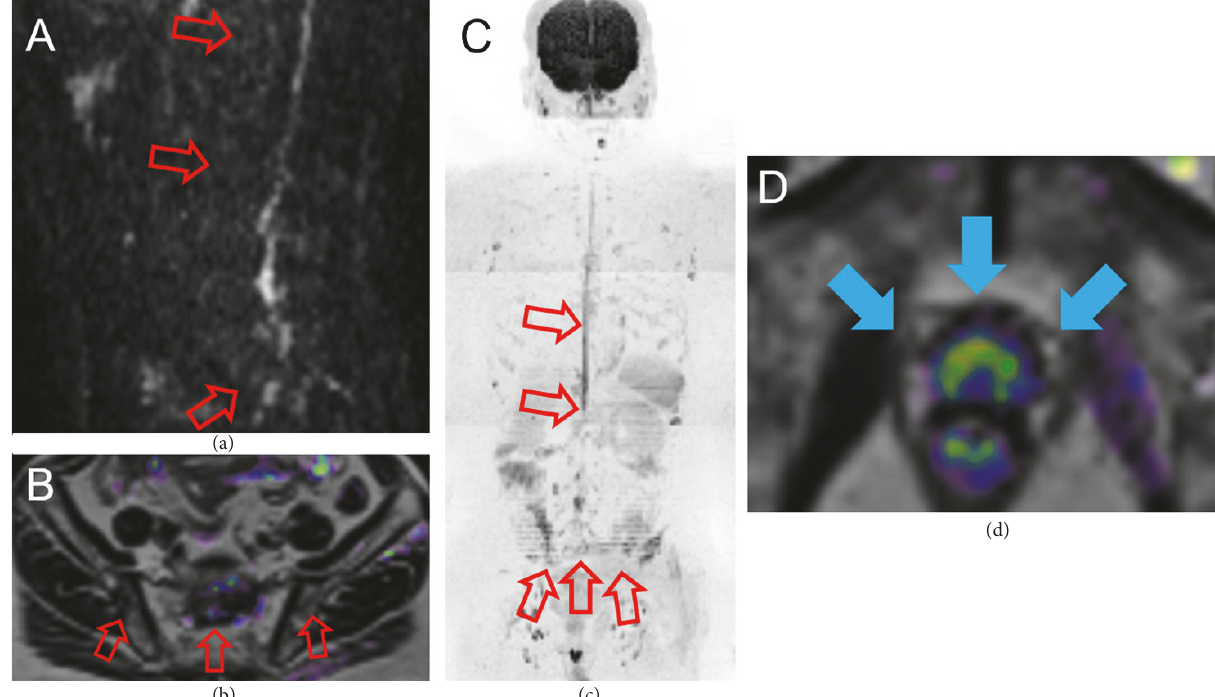
Figure 3: WB-MRI at the time of CRPC diagnosis. Sagittal DWI of the spine (a), coronal DWI + T2 fusion (b), and whole-body DWI (c) showed few high signals. Coronal DWI + T2 fusion of the pelvis (d) revealed diffuse high signal in the prostate. WB-MRI, whole-body magnetic resonance imaging; CRPC, castration-resistant prostate cancer; DWI, diffusion-weighted imaging.